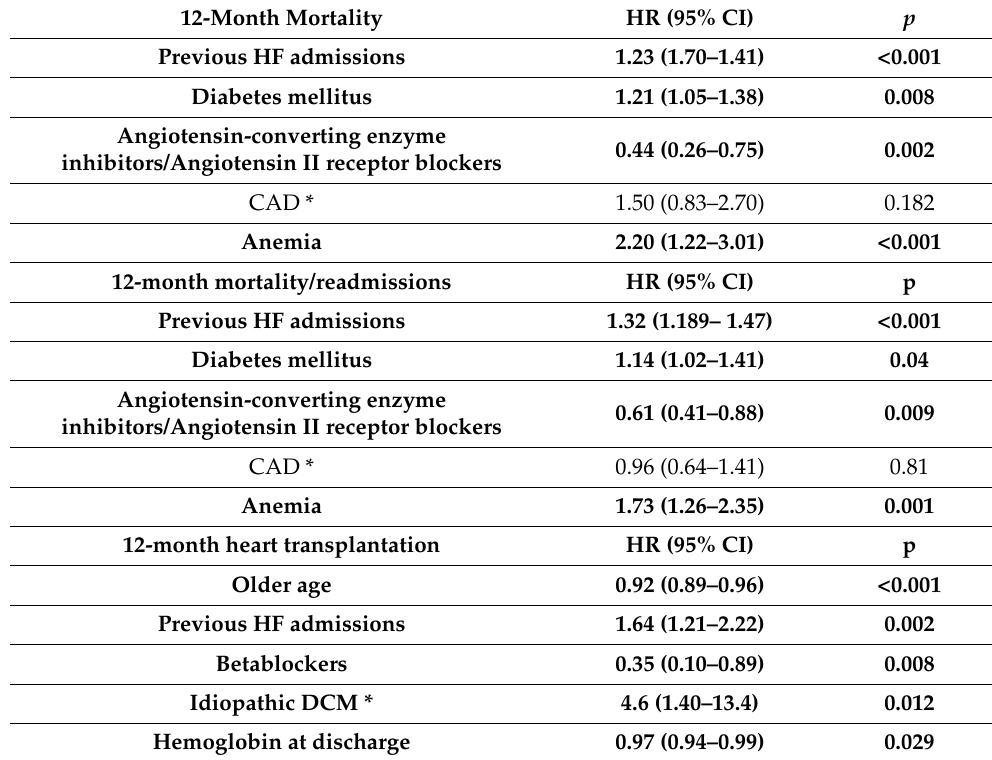
Table 4. Independent predictors of 12-month mortality and readmissions by Cox regression analysis.